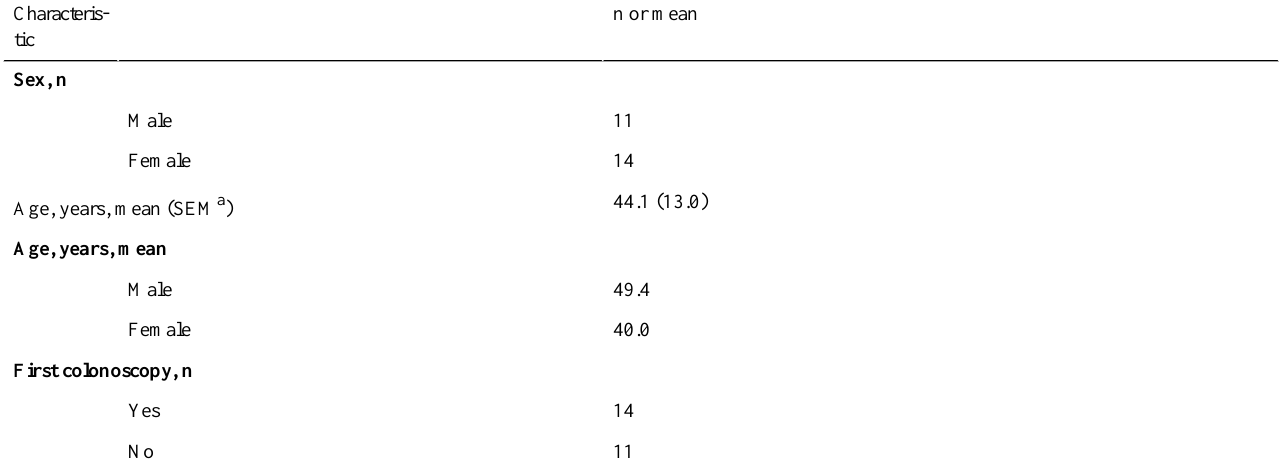
Table 1. General patient characteristics.